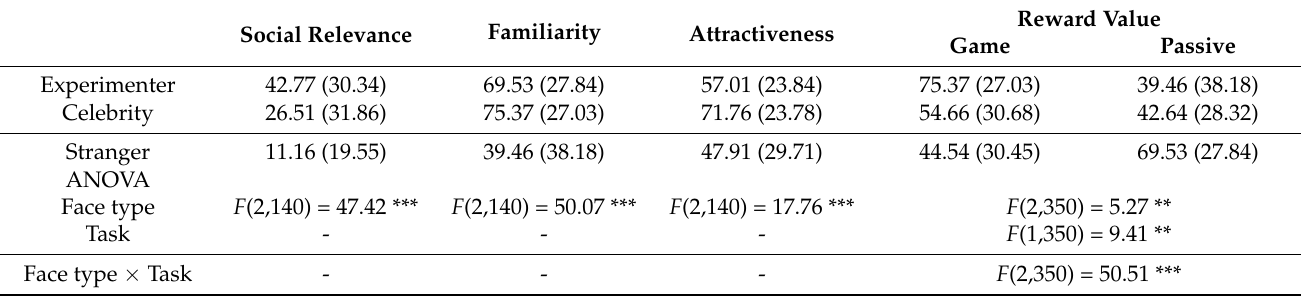
Reward Value Game Passive